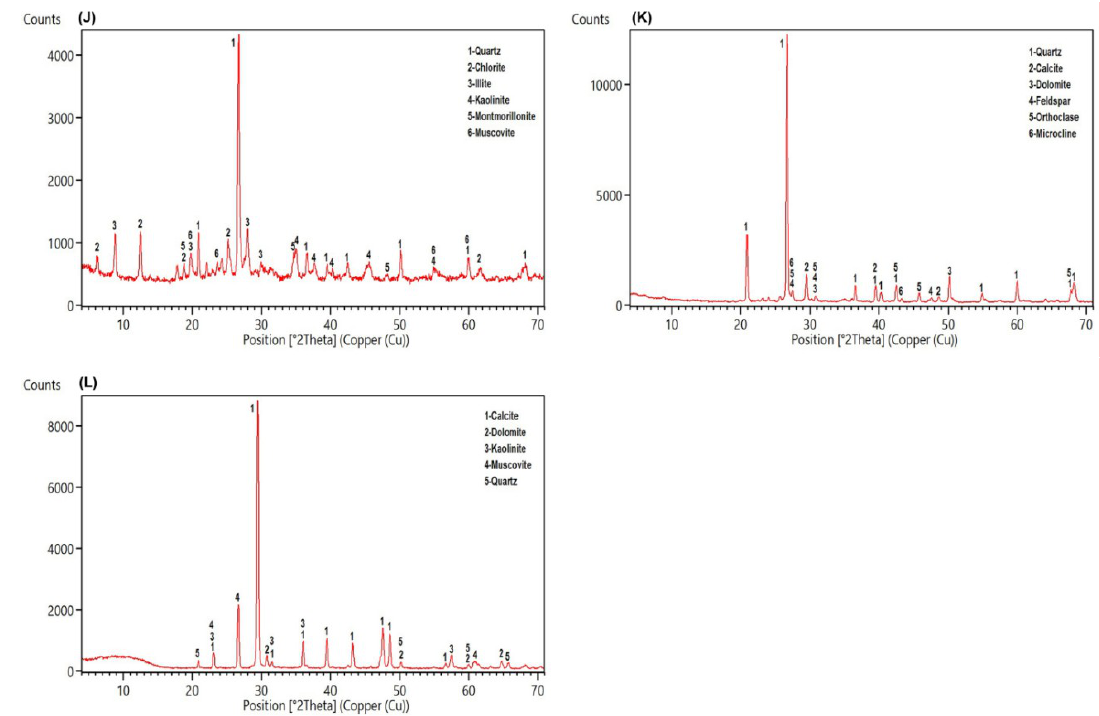
Figure 5. Results of XRD analysis shows minerals of representative samples collected from: ( A ) the Soltanieh Formation; ( B ) Bayandor Formation; ( C ) Deh-Sufiyan Formation (Mila group); ( D ) Elika Formation; ( E ) Lalun Formation (Mila group); ( F ) Fasham Formation (Mila group); ( G ) Lashkarak Formation (Mila group); ( H ) Shemshak Formation; ( J ) Barut Formation; ( K ) Deh-Molla Formation (Mila Group); and ( L ) Jeirud Formation.